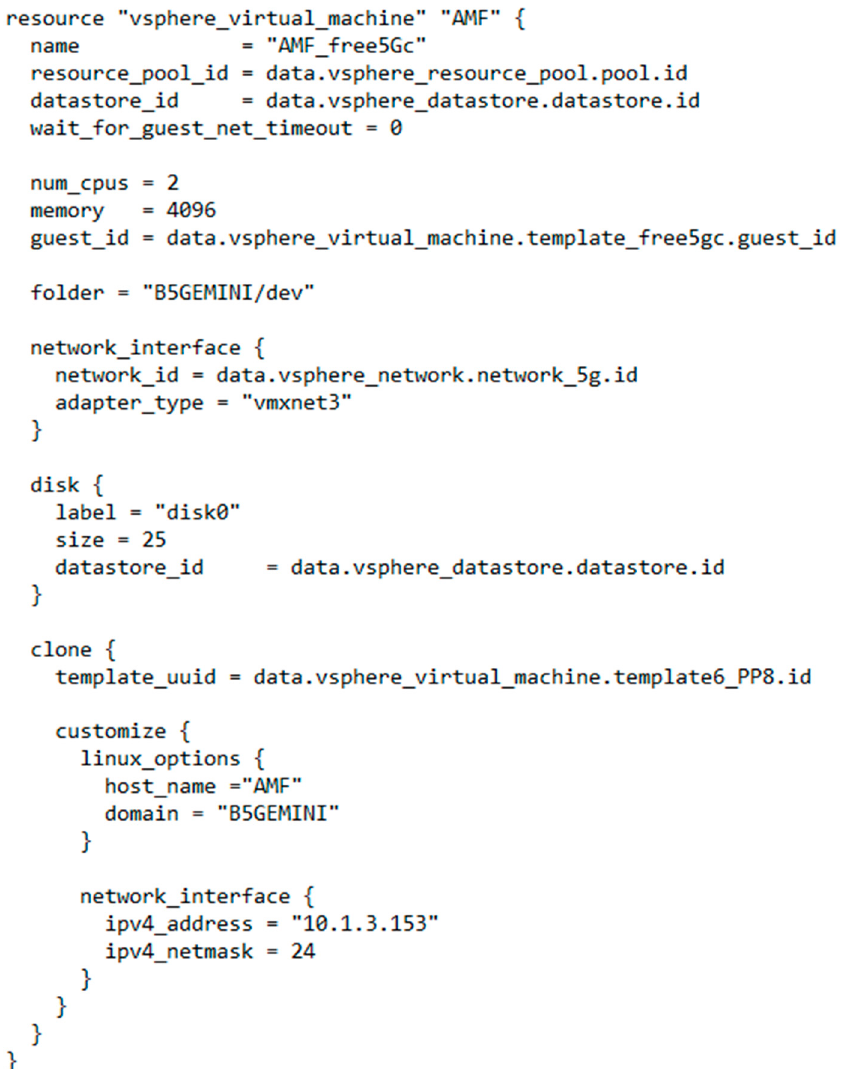
Figure 3. Example of deployment module for a specific resource via Terraform.